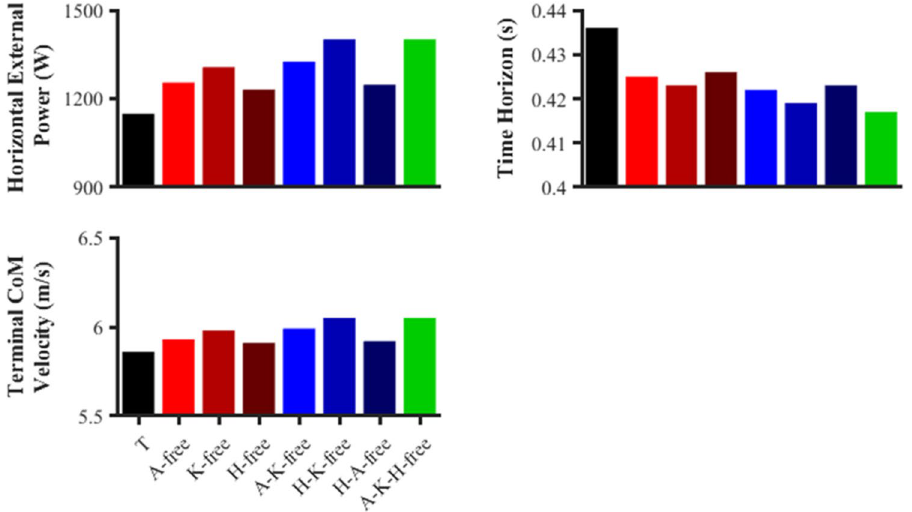
Figure 3. Metrics to quantify the sprint performance in the data-tracking (T) and predictive simulations (A-free, K-free, H-free, A-K-free, H-K-free, H-A-free,